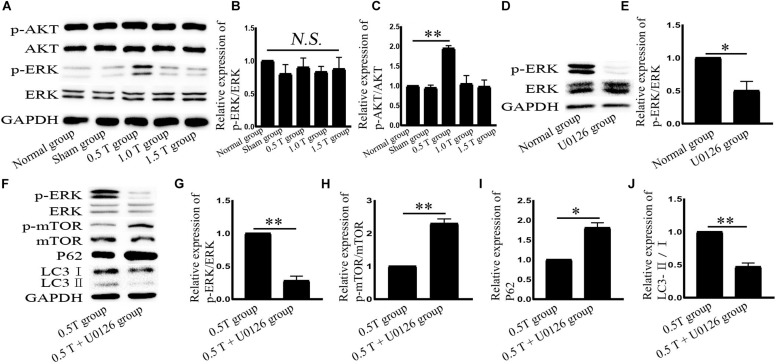
Repetitive transcranial magnetic stimulation (rTMS) activates ERK in bone mesenchymal stromal cells (BMSCs). (A) p-AKT, AKT, p-ERK, and ERK assessed by western blot. (B,C) Quantification of western blotting for p-AKT/AKT and p-ERK/ERK. Data were analyzed with a one-way ANOVA followed by Dunnett’s multiple comparison test. ∗∗P < 0.01. NS, not significant. n = 3. Error bars = SD. The value of p-ERK/ERK in the 0.5 T group was 1.950 ± 0.071. (D) p-ERK and ERK assessed by western blotting after normal group cotreatment with U0126. (E) Quantification of western blotting for p-ERK/ERK. Data were analyzed with a Student’s t-test. ∗P < 0.05, n = 3. Error bars = SD. The value of p-ERK/ERK in the U0126 group was 0.500 ± 0.141. (F) After cotreatment with U0126, ERK, p-ERK, p-mTOR, mTOR, LC3, and p62 were assessed by western blotting. (G–J) Quantification of western blotting for p-ERK/ERK, p-mTOR/mTOR, LC3-II/I, and p62. Data were analyzed with a Student’s t-test. ∗P < 0.05, ∗∗P < 0.01, n = 3. Error bars = SD. The values of p-ERK/ERK, p-mTOR/mTOR, p62, and LC3-II/I in the 0.5 T + U0126 treatment groups were 0.280 ± 0.071, 2.300 ± 0.141, 1.810 ± 0.127, and 0.470 ± 0.057, respectively. ERK, extracellular signal-regulated kinase; mTOR, mammalian target of rapamycin.